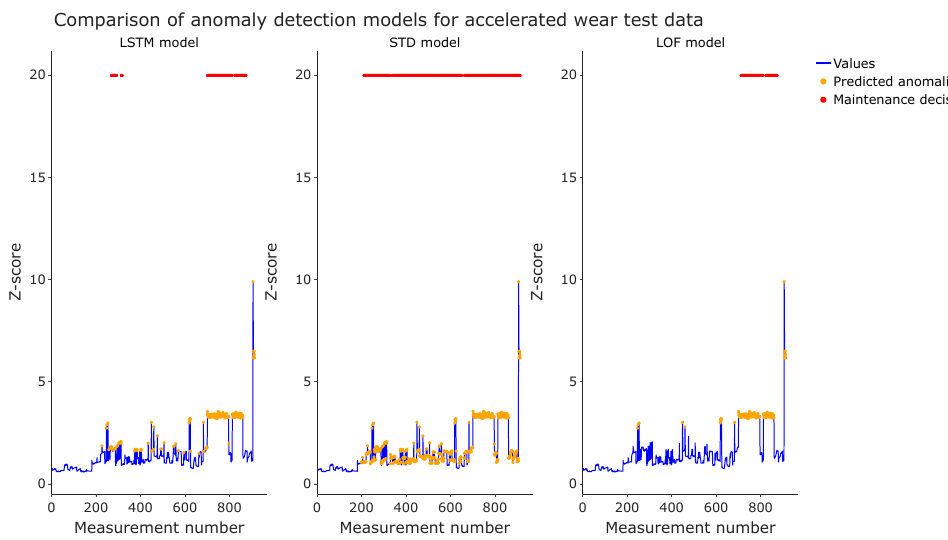
Figure 13. Results of selected anomaly detection models for accelerated wear test